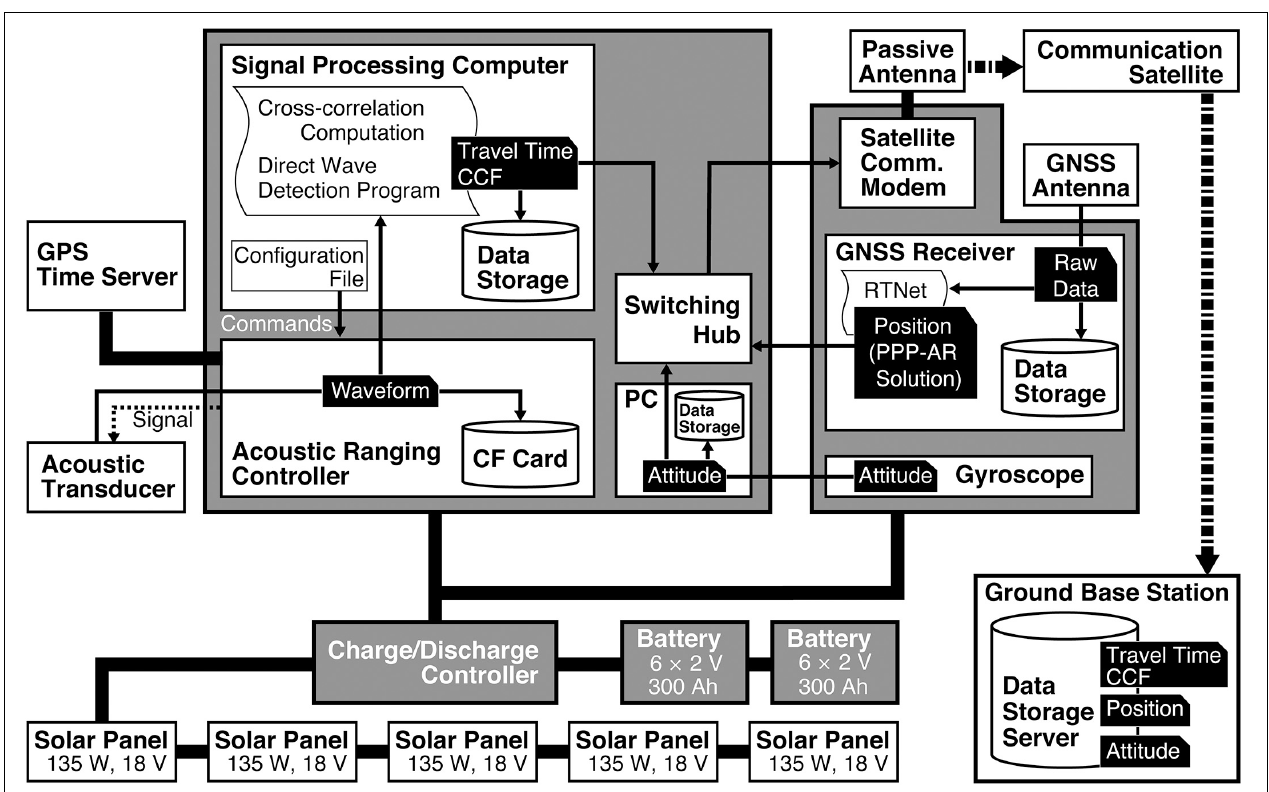
FIGURE 1 | Diagram showing system configuration of buoy-mounted components and data flow. Frames painted gray indicate the waterproof boxes.